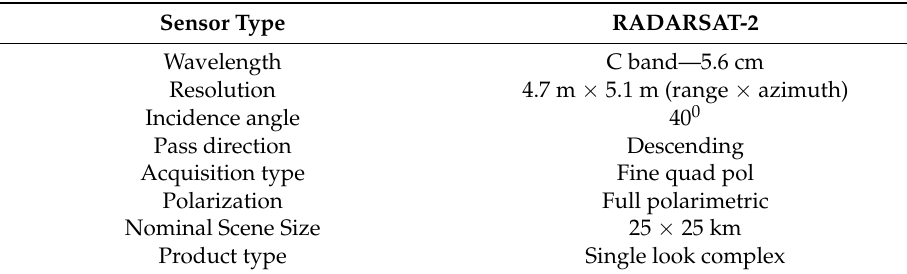
Figure 2. Images from different dates ( a ) 13 June, ( b ) 7 July, ( c ) 31 July, and ( d ) 24 August. Table 1. Image specifications.